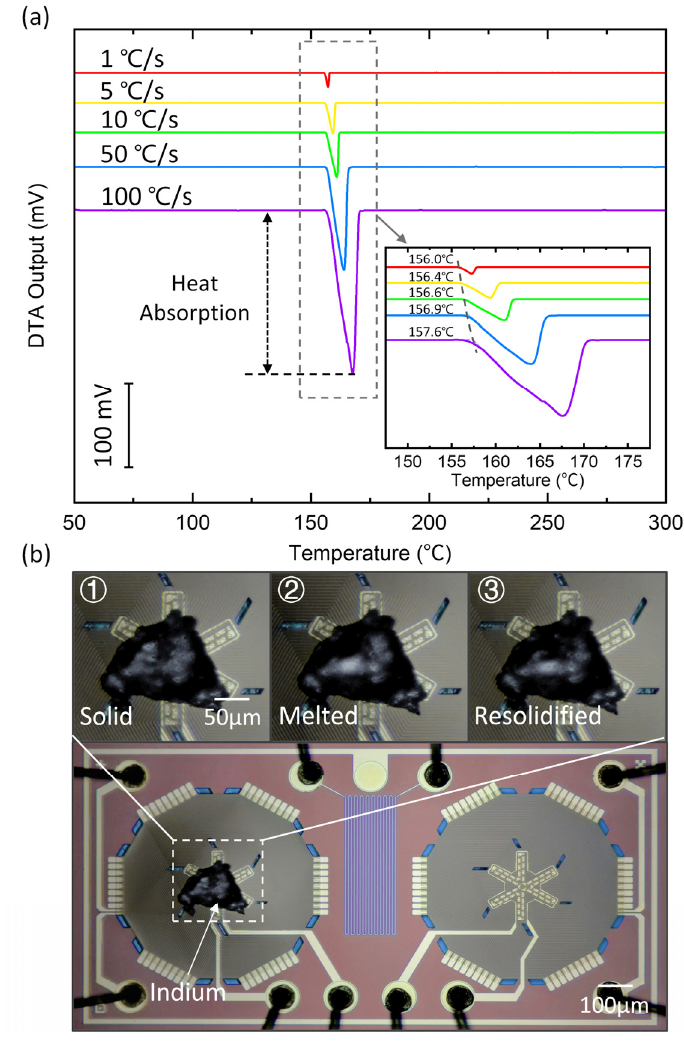
Figure 5. DTA measurement of indium melting using the MEMS thermopile sensors. ( a ) DTA output taken at different heating rates of 1–100 °C/s; the measured melting point is consistent with the reported value (156.6 °C), with a small thermal lag within 1 °C up to 100 °C/s. ( b ) Optical images showing the melting and resolidification of indium.